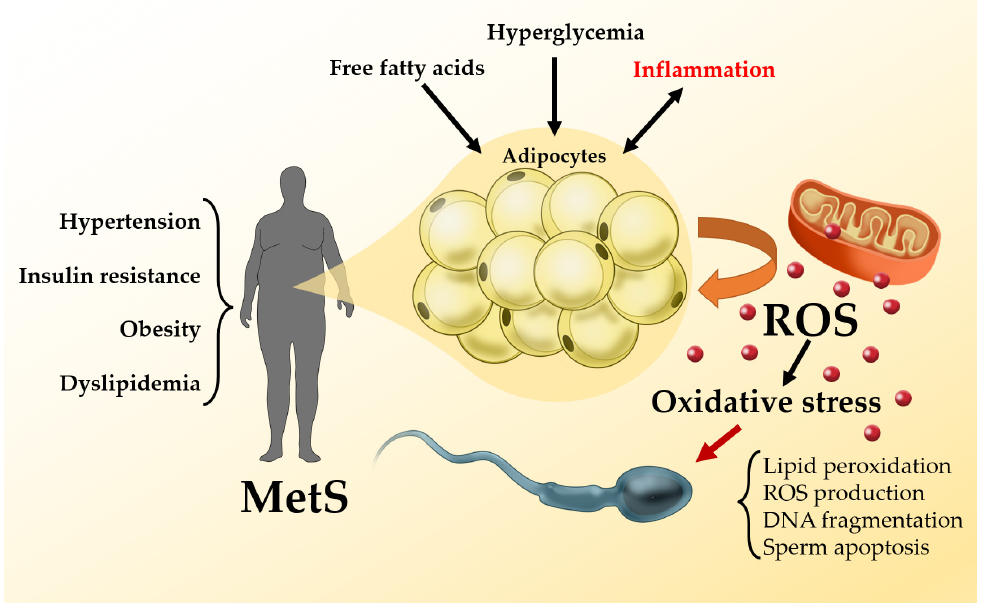
Figure 2. Metabolic syndrome (MetS) and oxidative stress (OS): hypertension, insulin resistance, obesity and dyslipidemia are the key-elements of MetS and they are all associated with increased OS. The latter derives from an imbalance between production an inactivation of reactive species of oxygen (ROS), which mainly derive from hyperreactive elements leaking from the mitochondrial electron transport chain. Free fatty acids, hyperglycemia and systemic inflammation contribute to sustain ROS production that in turn causes mitochondrial dysfunction and impairs cellular metabolism. High levels of intratesticular ROS, as observed in patients with MetS, may affect semen quality by causing structural and functional damage in the spermatozoa.